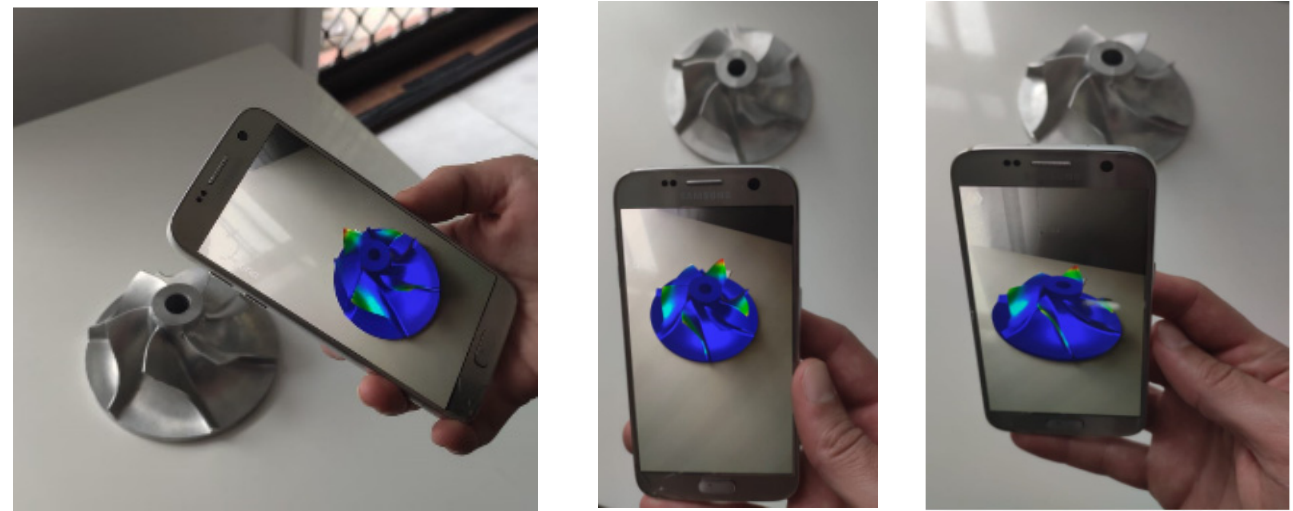
Figure 7. An AR Android package kit camera view.